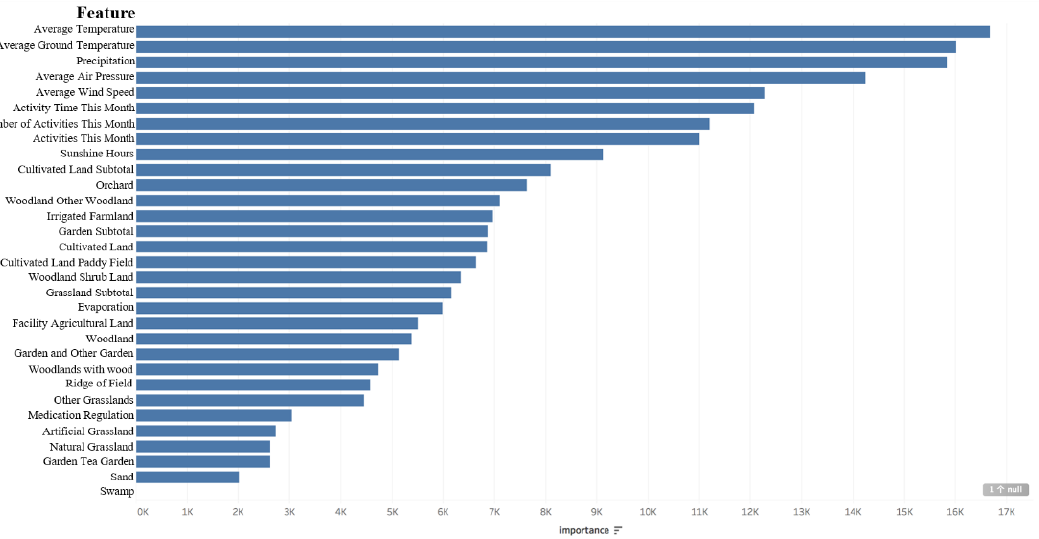
Figure 4. The importance ranking of features. Note that the features are average temperature,